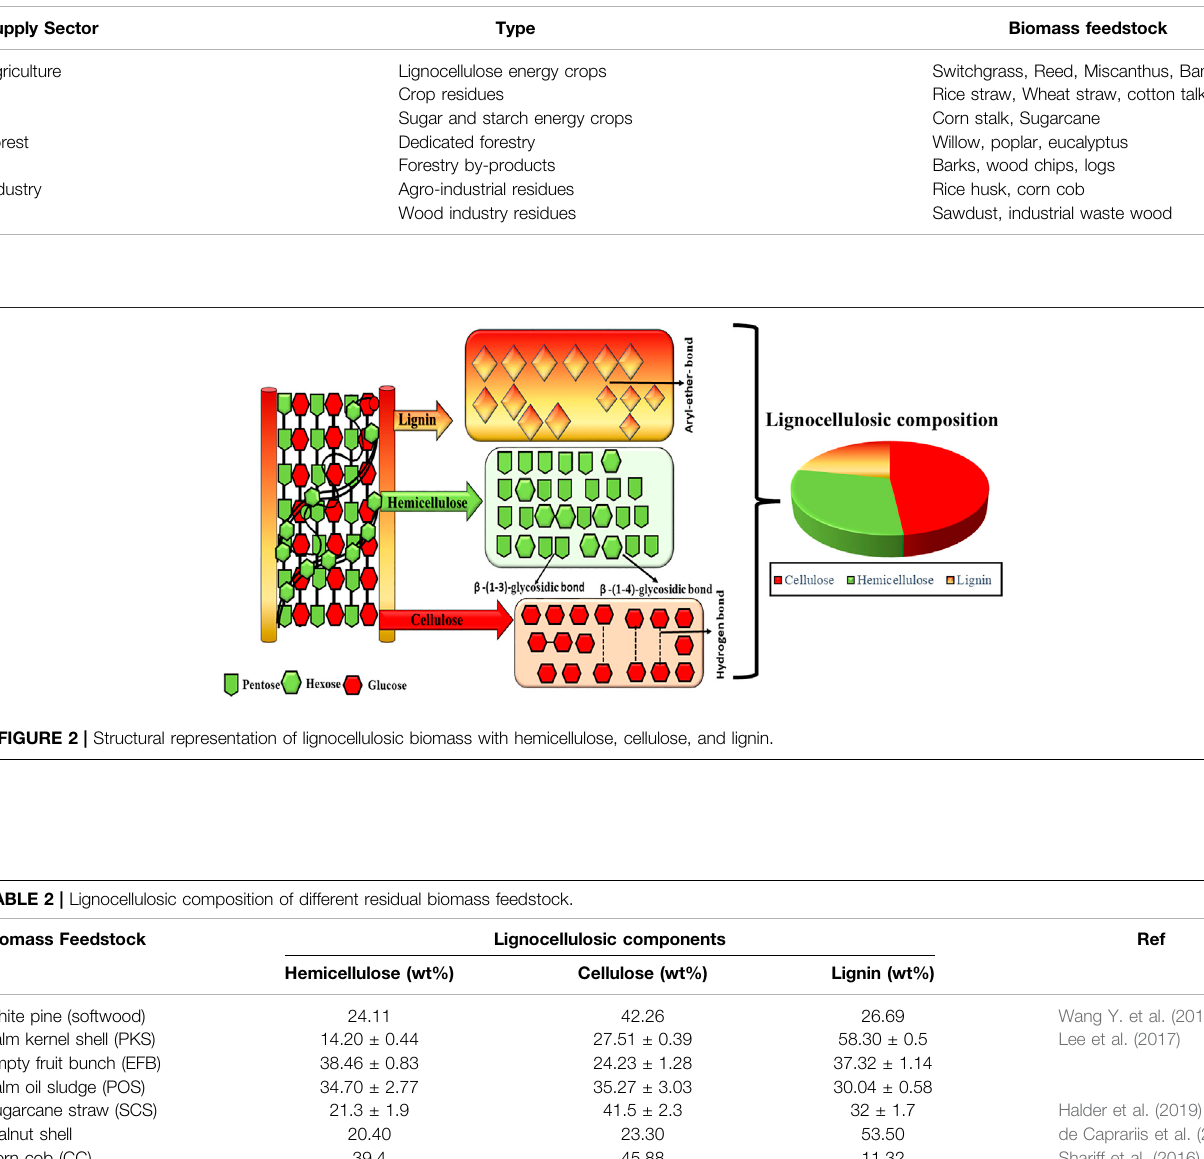
TABLE 1 | Lignocellulose biomass available for valorization (Cai et al., 2017).